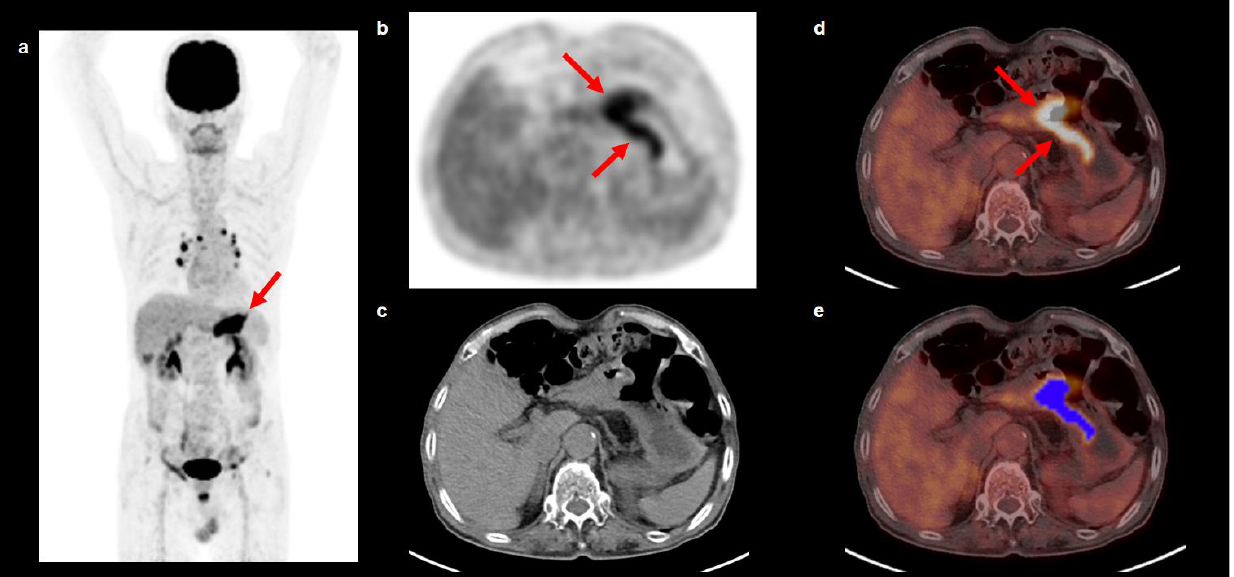
Figure 1. Maximal intensity projection image ( a ) and transaxial PET ( b ), CT ( c ), and fused PET/CT ( d , e ) images of FDG PET/CT showing an example of VOI for extracting textural features of gastric cancer. A 76-year-old man underwent FDG PET/CT for staging work-up of gastric cancer in the stomach antrum. The cancer lesion was histopathologically classified as tubular adenocarcinoma, the intestinal type, and showed intensely increased FDG uptake on PET/CT images with a maximum SUV of 8.28 (arrows on ( a , b , d )). A VOI was manually drawn around the gastric cancer lesion, and an area that showed a higher SUV than the threshold SUV of 3.45 determined by the modified Nestle’s adaptive threshold method was automatically selected within the VOI (blue color area in ( e )). The PET/CT textural features of the gastric cancer lesion were extracted from this